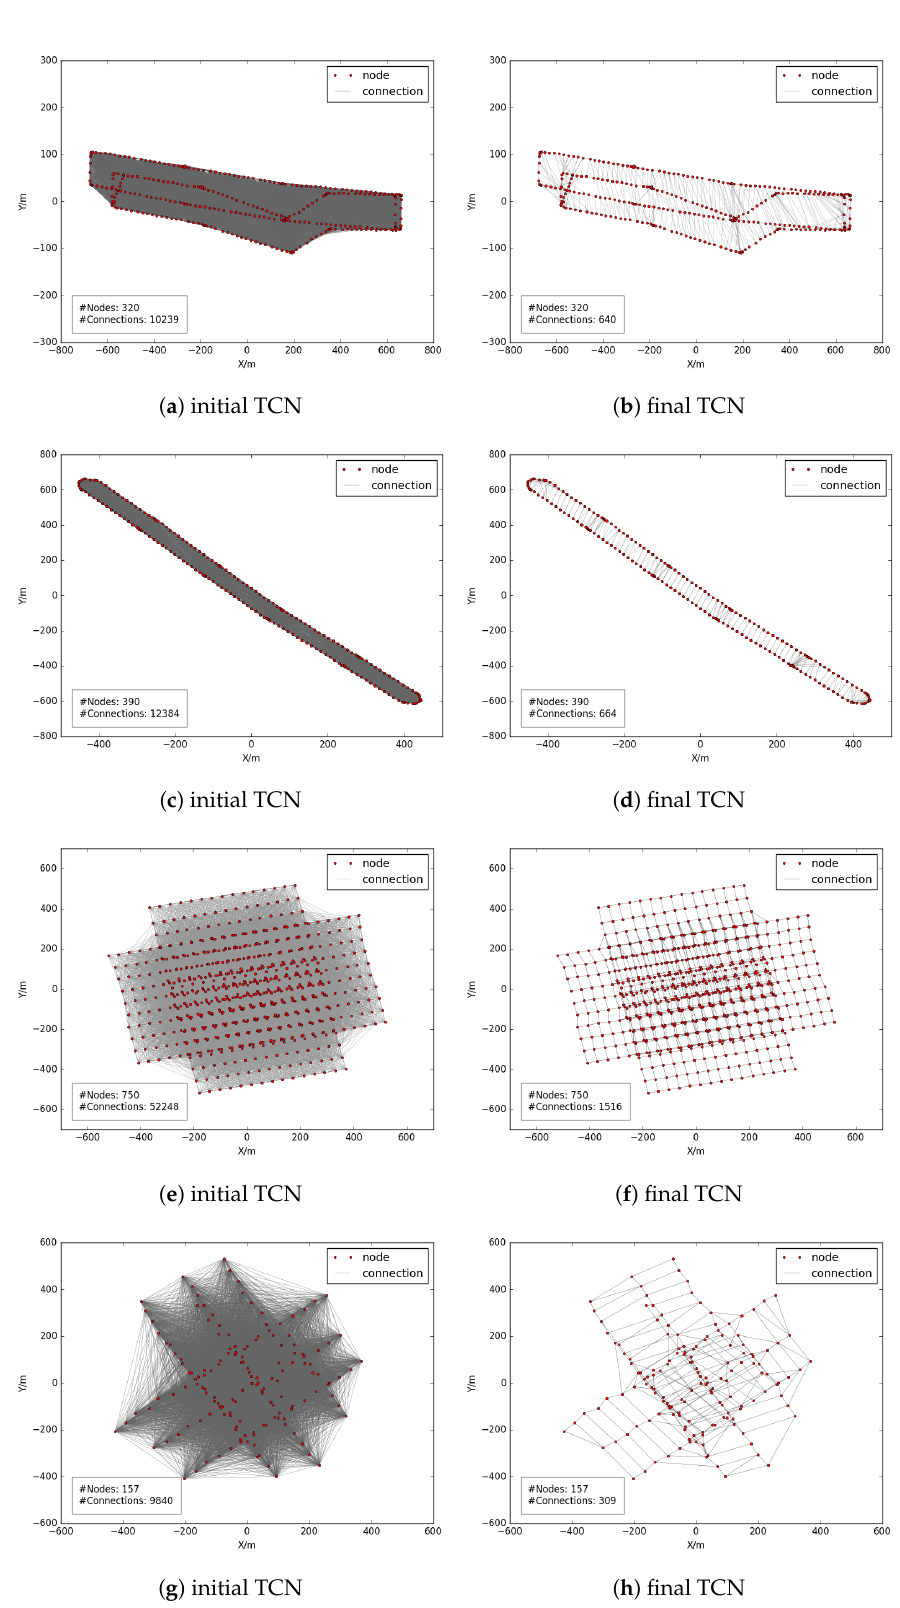
Figure 7. Image topological connection network: ( a , b ) dataset 1; ( c , d ) dataset 2; ( e , f ) dataset 3; ( g , h ) dataset 4